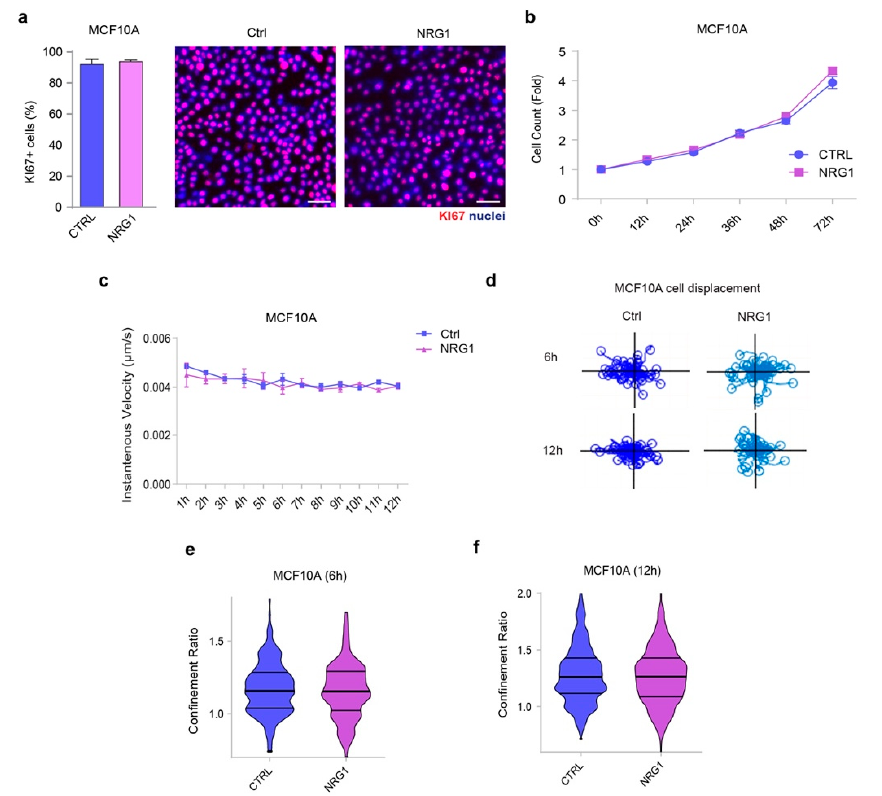
Figure 3. Proliferation and migration of basal-like/triple-negative breast cells cultured in monolayer conditions are not affected by the administration of the growth factor NRG1 β . ( a ) Immunofluores- cence analysis of KI67 for the evaluation of cells in the active phases of the cell cycle. MCF10A cells were cultured in vitro and treated with/without NRG1 β (10 ng/mL) for seven days. Subsequently, they were fixed and stained with an anti-KI67 antibody and DAPI (for nuclear staining) and examined with an inverted fluorescent microscope. Photoshop software was used to quantify KI67 positive cells of three different images taken for each sample. Representative pictures are provided; scale bar, 10 µ m. The histograms show the analysis of positively stained cells (means ± SEM) for MCF10A control and NRG1-treated cells, respectively. ( b ) Cell count analysis over time by Livecyte technology. MCF10A were cultured in vitro and treated with/without NRG1 β (10 ng/mL) and monitored up to 72 h. ( c ) Cell speed analysis over time by Livecyte technology of MCF10A cells treated with/without NRG1 β (10 ng/mL). Cell velocity has been detected every hour up to 12 h. ( d ) MCF10A cell displacement analysis by Livecyte technology. Representative track plots of MCF10A treated with/without NRG1 β (10 ng/mL) up to 6 and 12 h are provided. ( e , f ) Confinement ratio analysis of MCF10A cells by Livecyte technology. Violin plots of MCF10A treated with/without NRG1 β (10 ng/mL) for 6 and 12